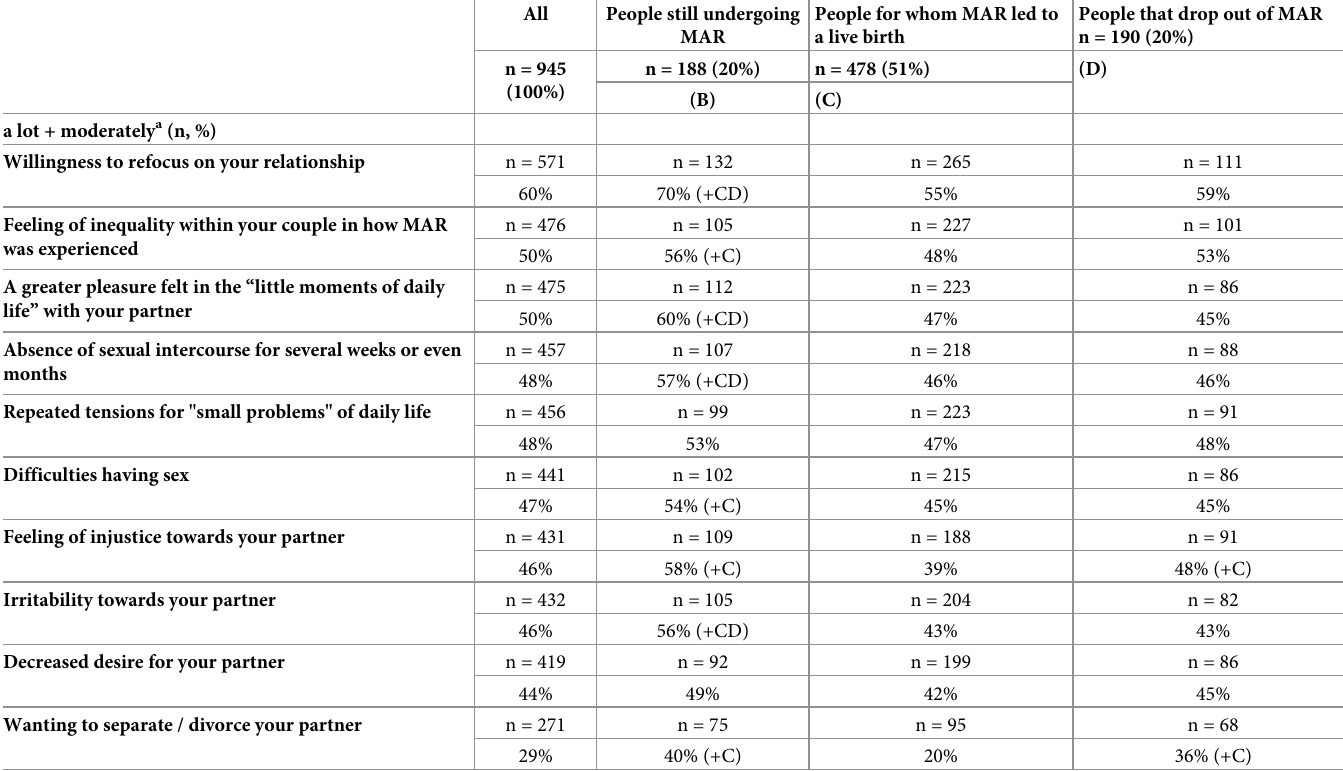
Table 3. A French national survey.